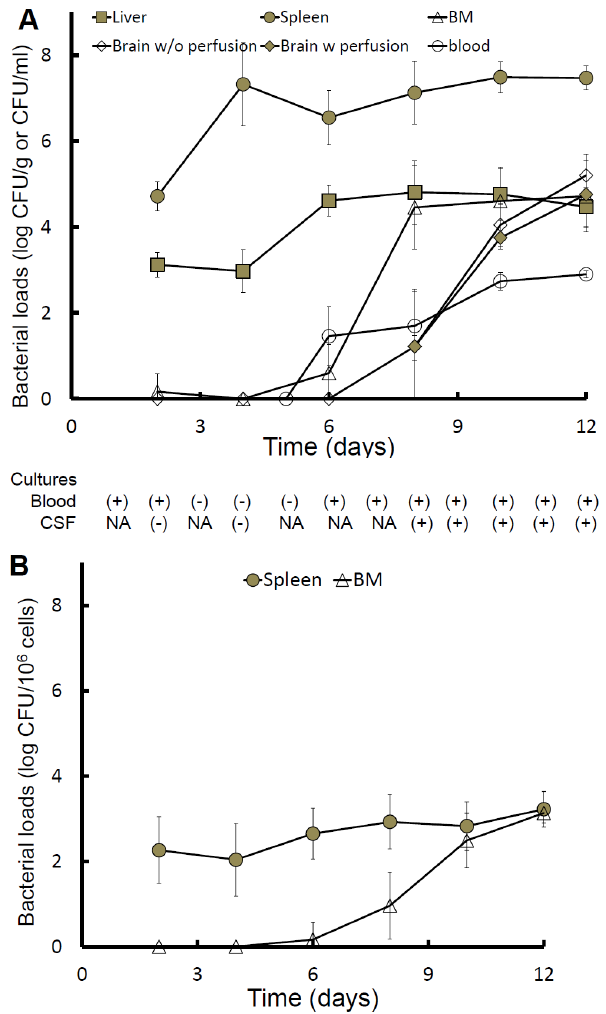
Figure 2. The kinetics of bacterial burdens in organs. At the indicated times, individual mice with melioidosis (n=6 for each point;